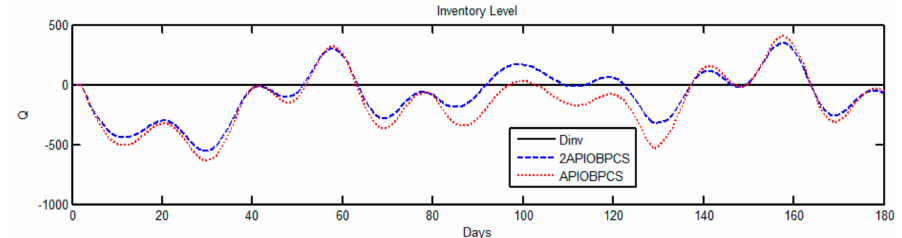
Figure 7. Simulation of Case 3 using Set 2 for the APIOBPCS and 2APIOBPCS models. Order rate ( top ) and inventory level ( bottom ).